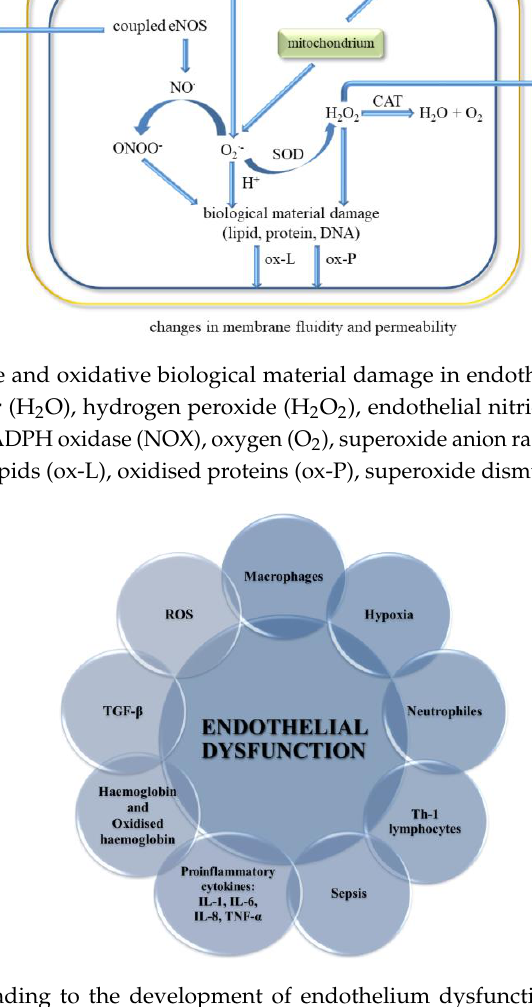
Figure 3. ROS release and oxidative biological material damage in endothelial cell. Abbreviations: catalase (CAT), water (H 2 O), hydrogen peroxide (H 2 O 2 ), endothelial nitric oxide synthase (eNOS), nitric oxide (NO • ), NADPH oxidase (NOX), oxygen (O 2 ), superoxide anion radical (O 2•− ), peroxynitrite (ONOO − ), oxidised lipids (ox-L), oxidised proteins (ox-P), superoxide dismutase (SOD).